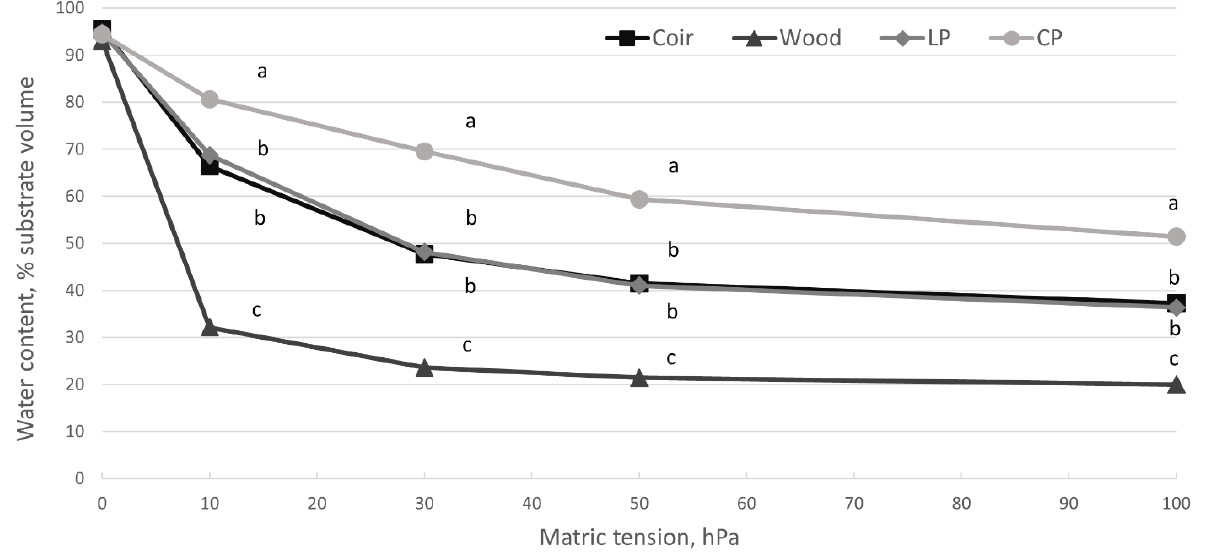
Figure 5. Water content of Coir, Wood, compressed peat (CP) and loose peat (LP) in sand box at 0, 10, 30, 50 and 100 hPa matric tension, as percentage of the total substrate volume. Vertical bars present ± SE (n = 3). Different lowercase letters indicate statistically significant differences between the levels within each substrate (P < 0.05) by Tukey’s test.